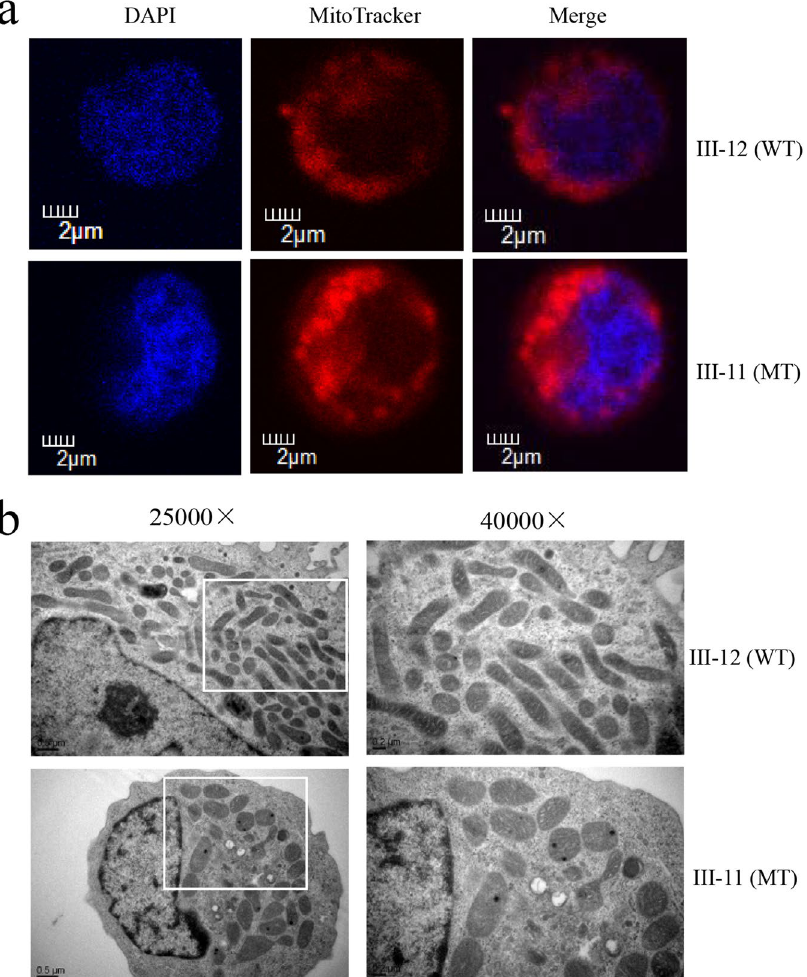
Figure 1. The OPA1 mutation altered the fragmentation of the mitochondrial network. ( a ) Mitochondrial morphology was visualized by immunofluorescent labeling with MitoTracker (red) and was analyzed by confocal microscopy using lymphoblastoid cell lines. DAPI-stained nuclei were identified by their blue fluorescence. Internal control cell (III-12) lacking the OPA1 mutation exhibited a balanced mitochondrial network of the filamentous and fragmented states. Cells carrying the OPA1 mutation (III-11) displayed a distinct punctate pattern of mitochodnria. ( b ) Mitochondrial networks from patient and control cells were examined by transmission electron microscopy. Ultrathin sections were stained with uranyl acetate and alkaline lead citrate. 25,000X and 40,000X magnifications were used. Control lymphoblastoid cell lines (III-12) have tubular distribution of mitochondria. Patient-derived lymphoblastoid cell lines (III-11) have spotty distribution of